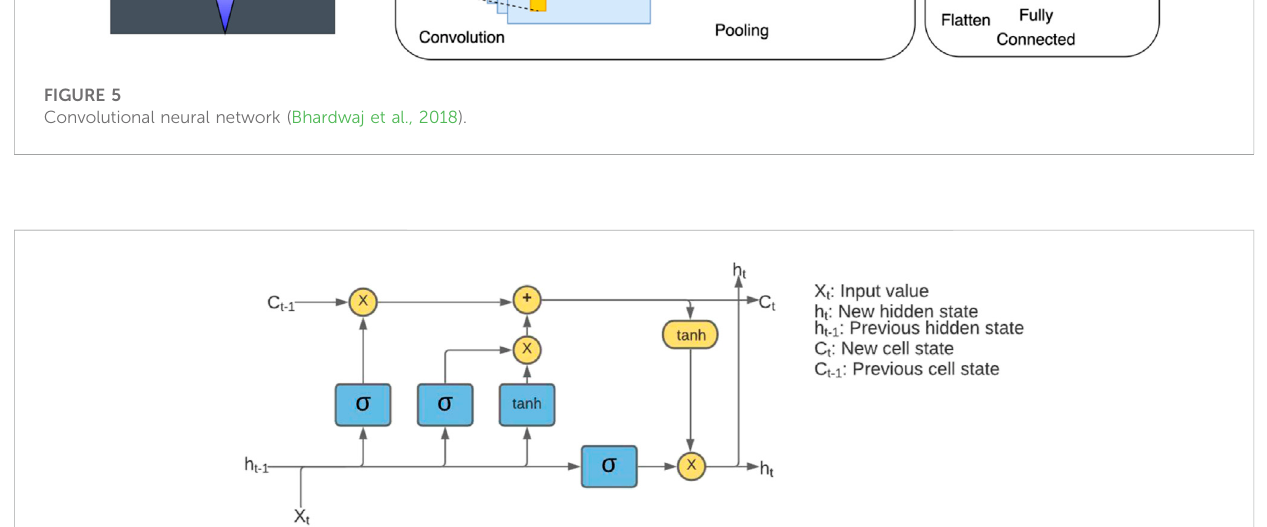
FIGURE 6 Long short-term memory model (Bhardwaj et al.,